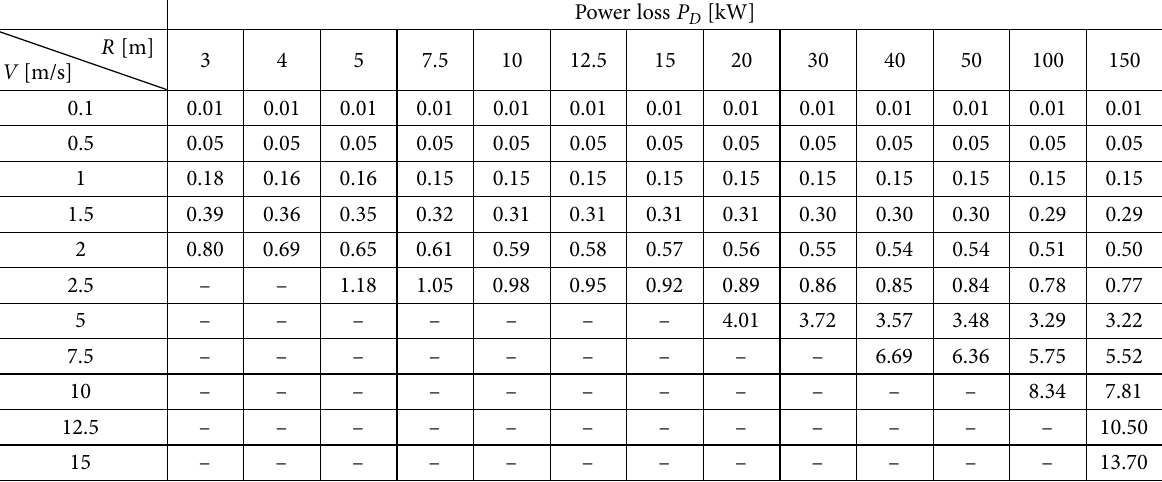
Fig. 10. Distances between the rolls of left rear quarter of the vehicle and the edge of the rail (simulation result) Table 1. Results of calculations of additional power loss as a function of speed and the radius of the curve obtained by simulation of real-sized vehicle motion